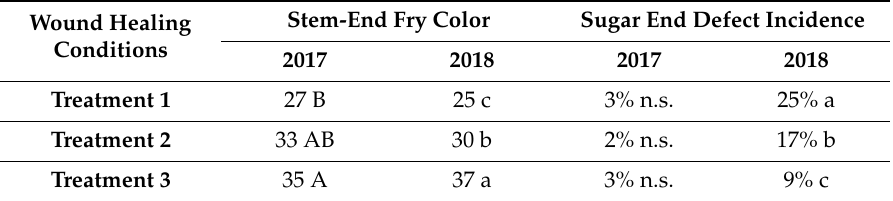
Table 4. Photovolt readings at the stem end and sugar end defect incidence of French fries processed from Russet Burbank potatoes, under di ff erent wound healing conditions in each year. (n.s. not significant, numbers followed by di ff erent letters are significantly di ff erent at α =